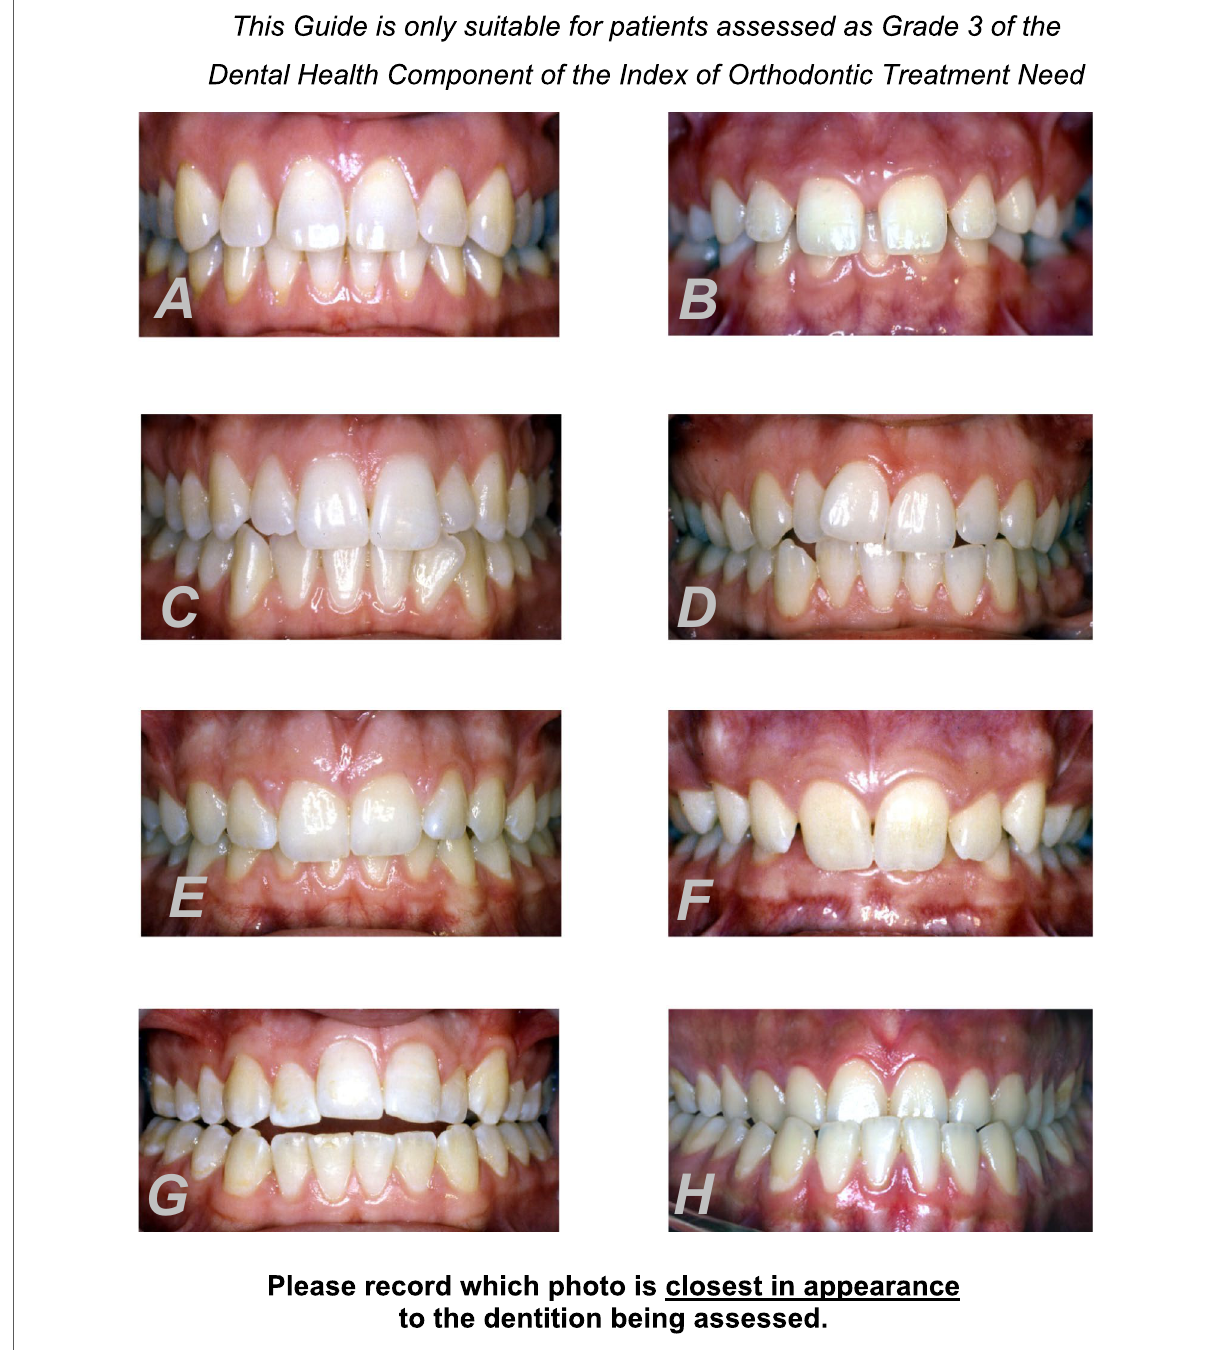
Fig. 1 Guide to borderline orthodontic need